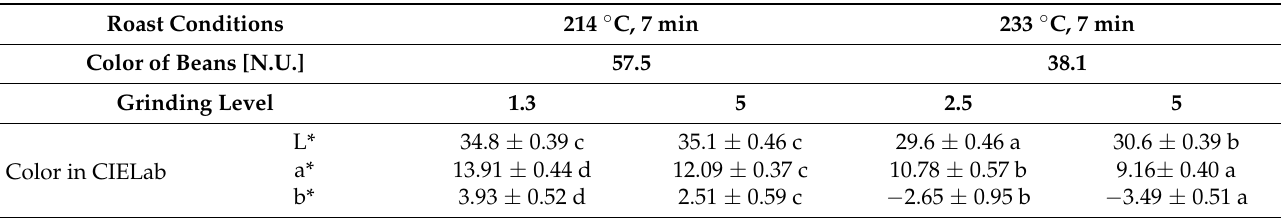
Table 1. Characteristics of coffee